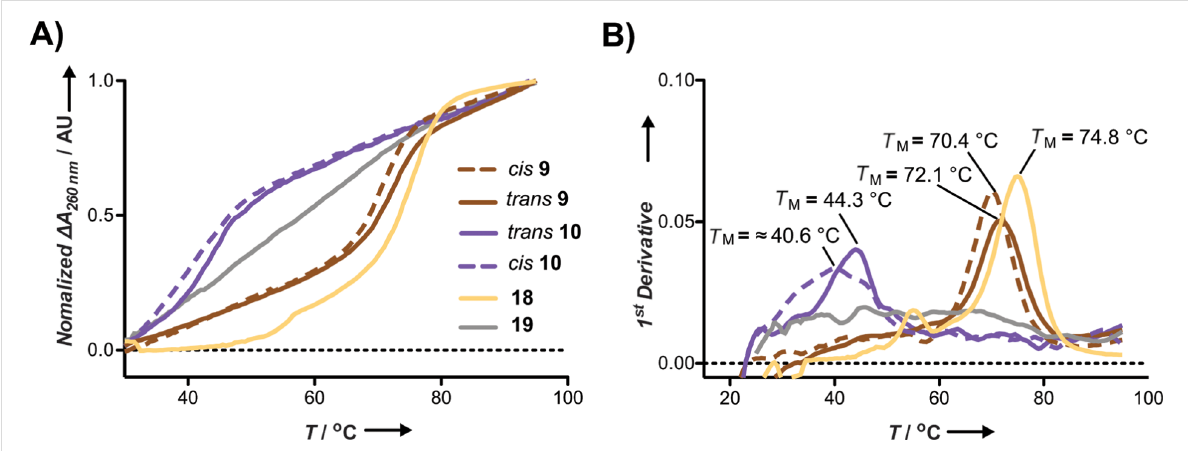
Figure 3: A) Melting curves of a 1 µM duplex solution in phosphate buffer (10 mM NaH 2 PO 4 , 150 mM NaCl, pH 7.4) of the PNA ( 18 = yellow solid line; 19 = grey solid line; 9 = brown, cis dashed line, trans solid line; 10 = purple, cis dashed line, trans solid line and the complementary ssDNA (5’-GTG AGC CAA GAA ACA CTG CCT-3’)). The melting curves were duplicates from two independent experiments combining 3 cycles of measure- ments from 20 °C to 95 °C at 260 nm without pre-hybridization. B) Melting temperatures ( T M ) obtained by the first derivative of the data in A.